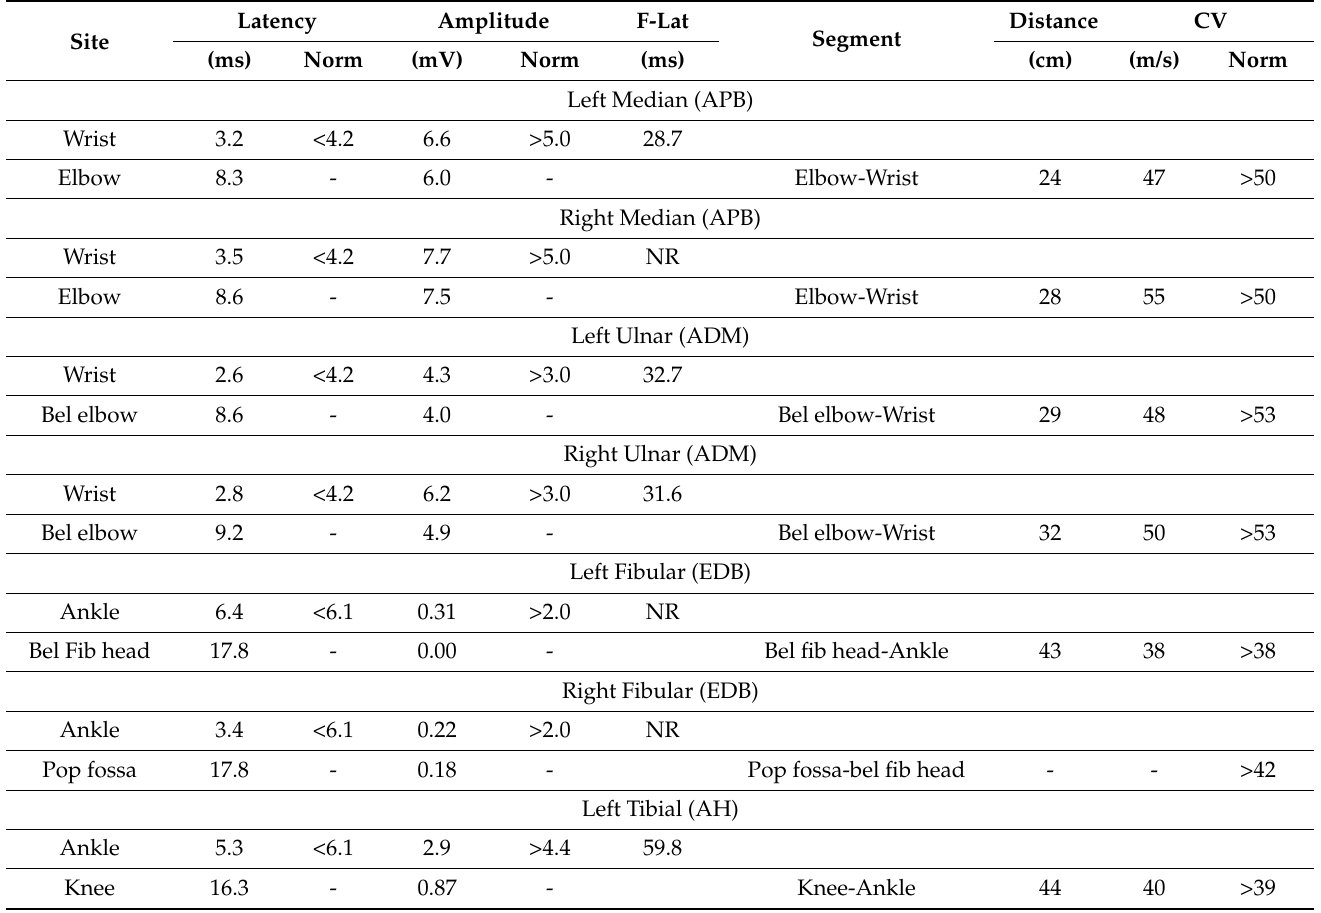
Table 2. The study of peripheral, motor nerve conduction velocities shows a moderate to severe motor polyneuropathic process, with a mixed pattern but axonal predominance that affects the four extremities with greater expression in the lower extremities and predominance on the